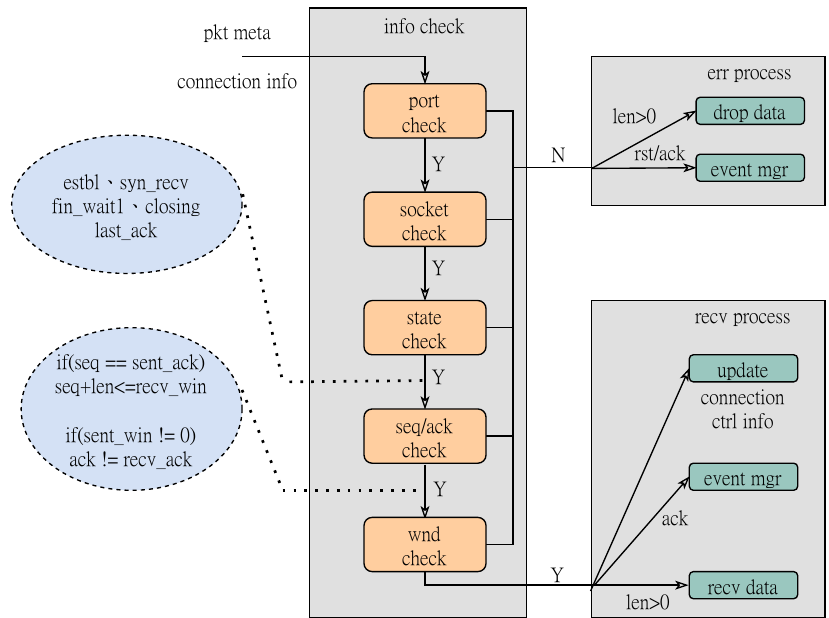
Figure 2. Rx data receiving